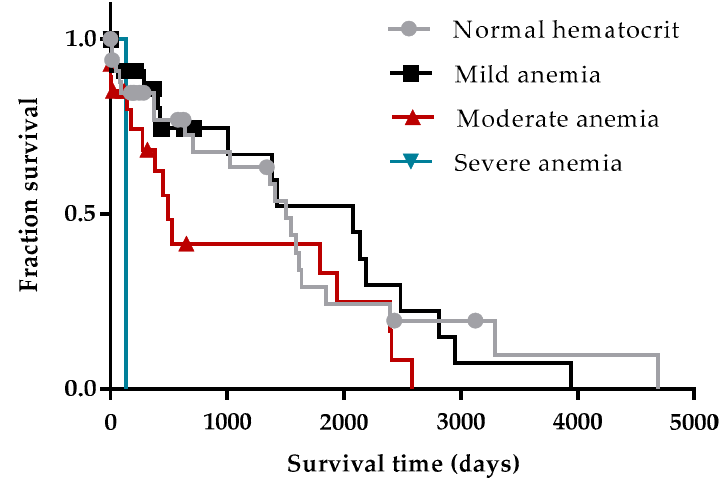
Figure 2. Influence of hematocrit value at the time of diagnosis on the survival time of patients with CanL. Log-rank (Mantel-Cox) test was used to compare the survival time of patients with normal hematocrit values, mild, moderate and severe anemia. Both events (death) and censored data were considered. Dots, triangles and squares represent censored